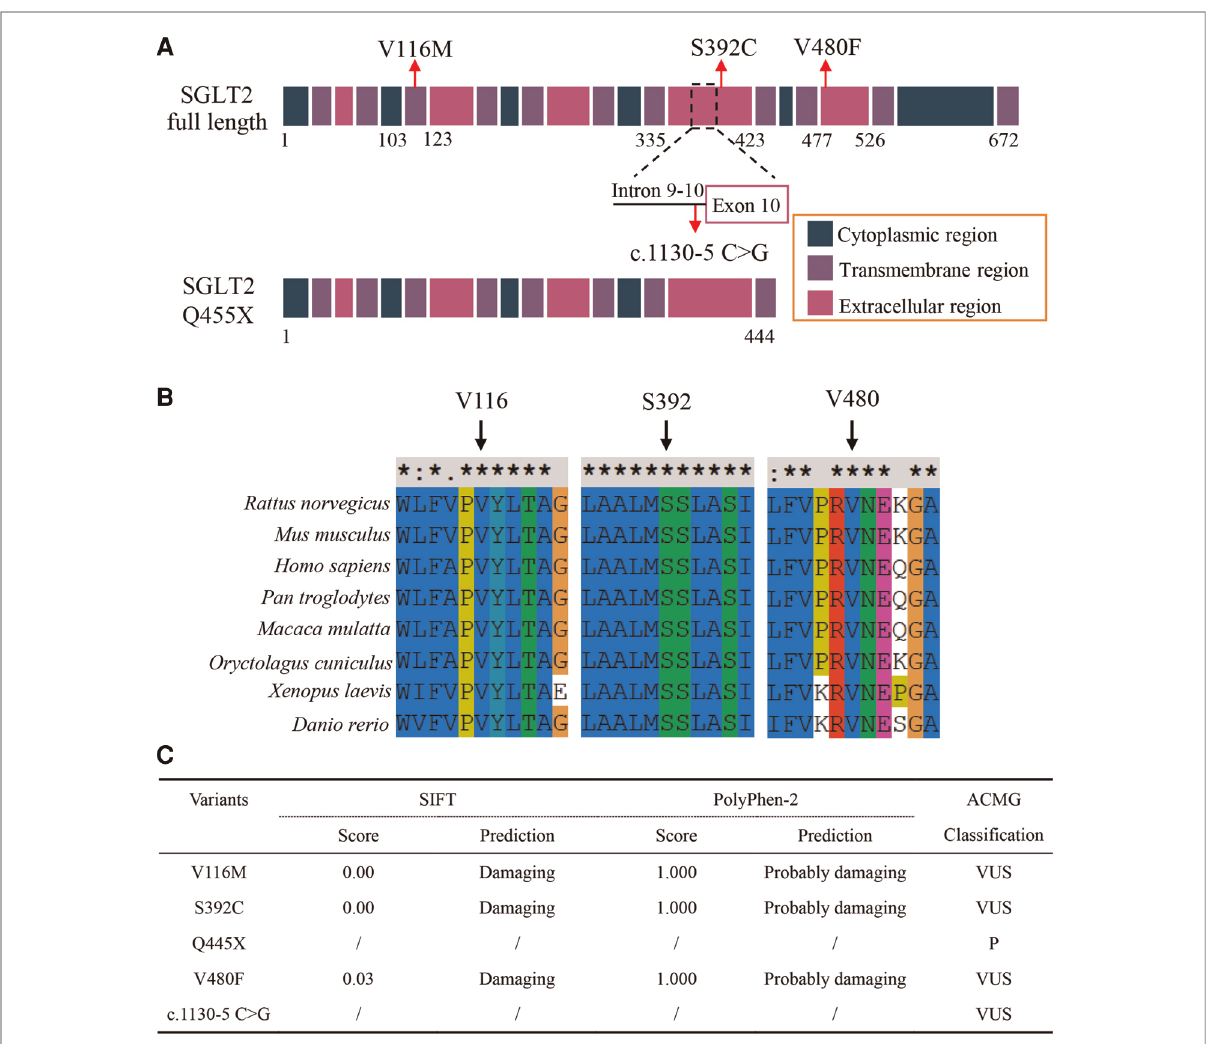
FIGURE 2 ( A ) Schematic illustration showing SGLT2 protein domains with loci affected by variants indicated. ( B ) Multiple sequence alignment of the SGLT2 protein from different vertebrate species. Arrows indicate amino acids affected by missense variants, which are highly conserved. ( C ) Prediction of the effects of variants on SGLT2 protein function and ACMG classi fi cation of the variants. For ACMG classi fi cations: V116M, VUS (PM2+PP1+ PP3+PP4); S392C, VUS (PM2+PP1+PP3+PP4); Q455X, P (PVS1+PM2+PP1+PP3+PP4); V480F (PM2+PP1+PP3+PP4); c.1130-5 C>G, VUS (PM2+PP1+PP3+PP4). VUS, uncertain signi fi cance; P, pathogenic. PVS1, null variants (nonsense); PM2, not present (or at extremely low frequency) in normal population; PP1, co-segregation in the families; PP3, predicted to be pathogenic by multiple bioinformatic tools; PP4, family history is highly speci fi c with a single genetic